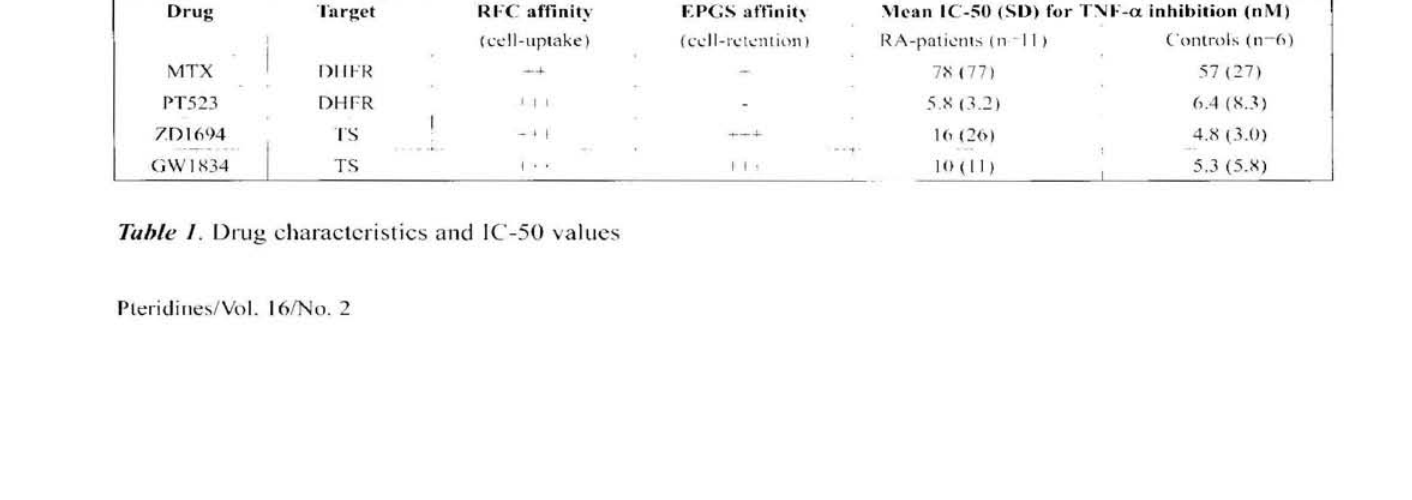
Table 1. Drug charactcristics and lC-50 values